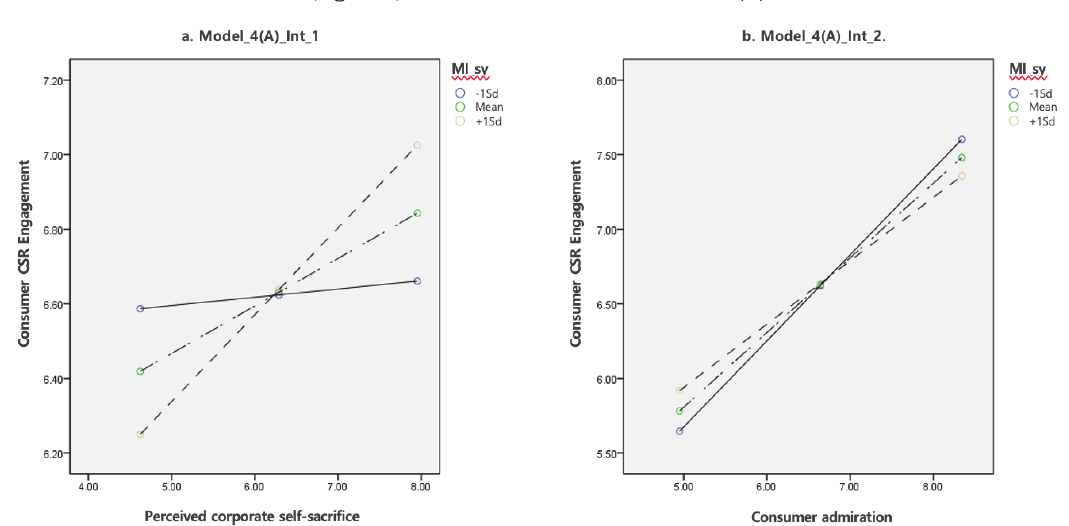
<Figure 5> The Interaction Effect of Model